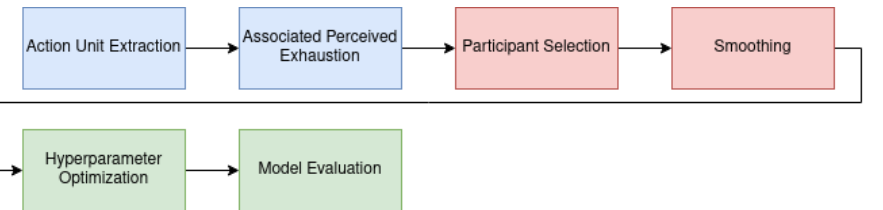
Figure 3. Data processing pipeline consists of an Action Unit (AU) Extraction from videos using OpenFace. The AUs are stored together with the participant’s subjective perceived exhaustion on the Borg10 scale. Following, participants are manually assigned labels regarding whether they are smiling and whether they subjectively look exhausted. The time series is then smoothed using various filters. Finally, hyperparameters are tuned using a validation set, and the model is